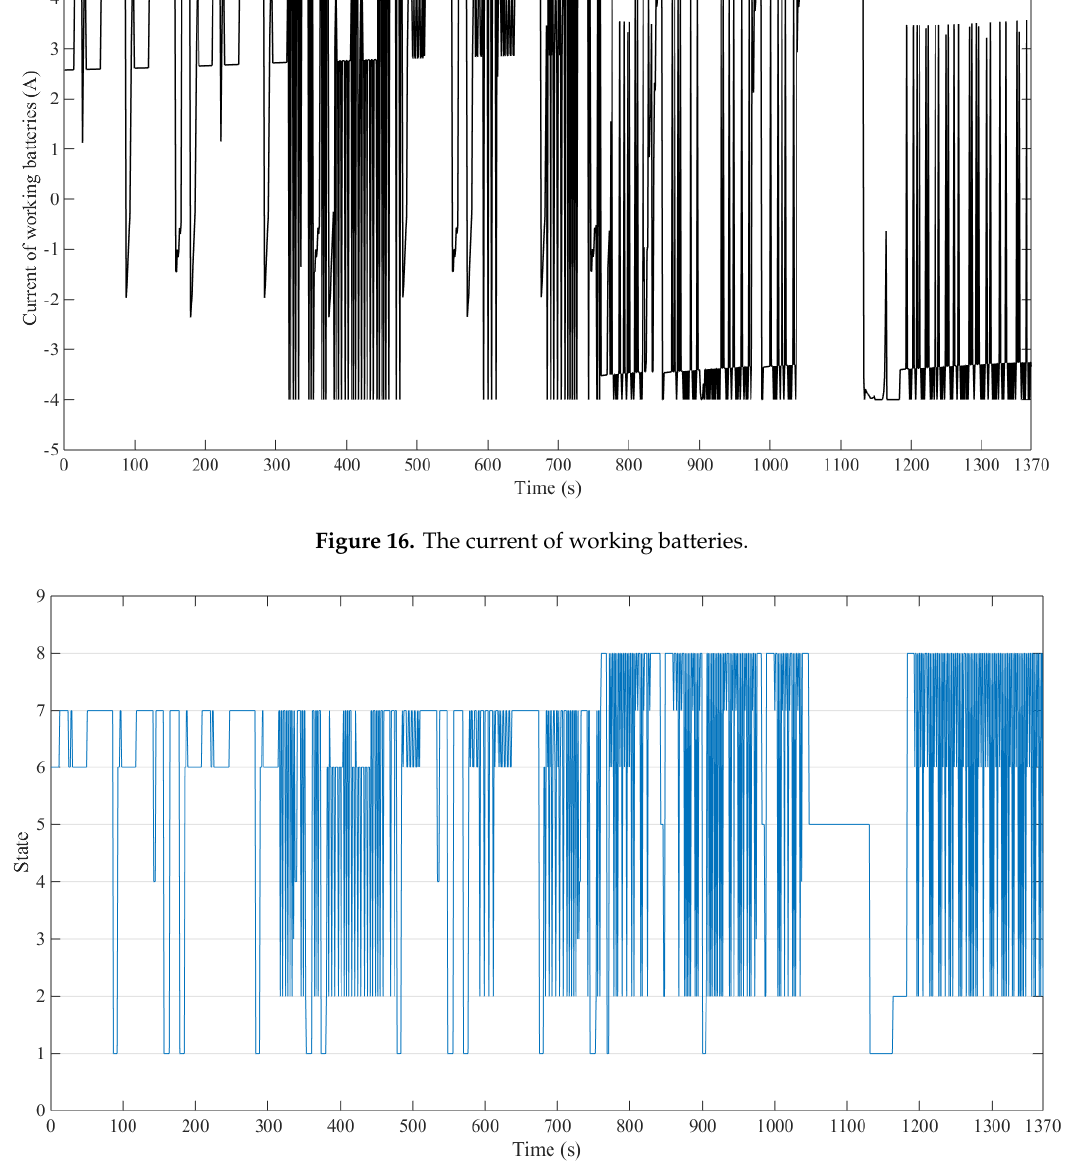
Figure 17. The state change of the switched energy management strategy.